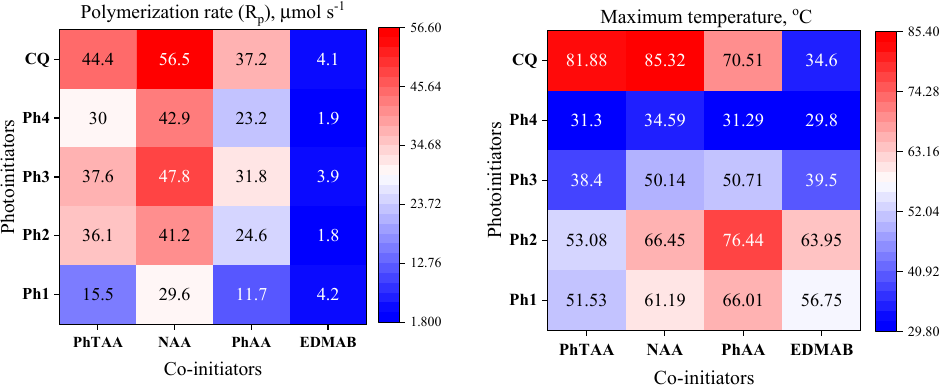
Figure 1. Comparison of temperature changes during irradiation of monomer composites contain- ing synthesized photoinitiators and commercial camphorquinone. Photoinitiating systems include: –Ph1 (dibenzo[a,c]phenazine), –Ph2 (benzo[a]phenazine), –Ph3 (11 H -indeno[1,2-b]quinoxalin- 11-one), –Ph4 (6 H -indolo[2,3-b]quinoxaline) and –CQ (camphorquinone) as photoinitiator, and 1-naphthoxyacetic acid (NAA; c = 0.1 M) as co-initiator. I = 15 mW/cm 2 . Figure 2. Heatmaps of the polymerization rate ( µ mol s − 1 ) ( left ) and maximum temperature rise ( right ) during photoinitiated polymerization of TMPTA; photoinitiating systems consisted of pho- toinitiators: dibenzo[a,c]phenazine (Ph1), benzo[a]phenazine (Ph2), 11 H -indeno[1,2-b]quinoxalin- 11-one (Ph3), 6 H -indolo[2,3-b]quinoxaline (Ph4) and camphorquinone (CQ), and co-initiators: (phenylthio)acetic acid (PhTAA), 1-naphthoxyacetic acid (NAA), phenoxyacetic acid (PhAA) and ethyl 4-dimethylaminobenzoate (EDMAB). Table 1. Photoinitiator concentration in the tested polymer composite: dibenzo[a,c]phenazine (Ph1), benzo[a]phenazine (Ph2), 11 H -indeno[1,2-b]quinoxalin-11-one (Ph3), 6 H -indolo[2,3-b]quinoxaline (Ph4) and camphorquinone